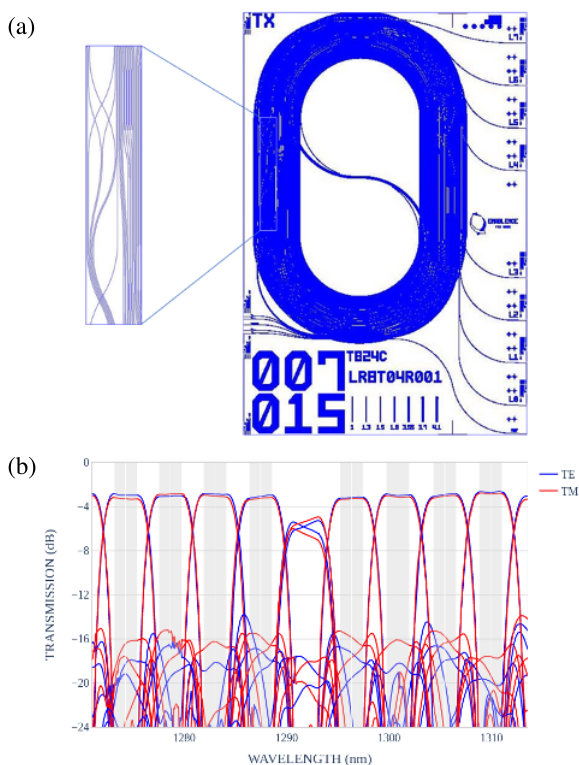
Fig. 1. (a) An 8-channel LAN-WDM multiplexer chip. The inset shows a zoomed-in view of the structure required for the reordering of the multiplexer channels. (b) Measured transmission spectra of the